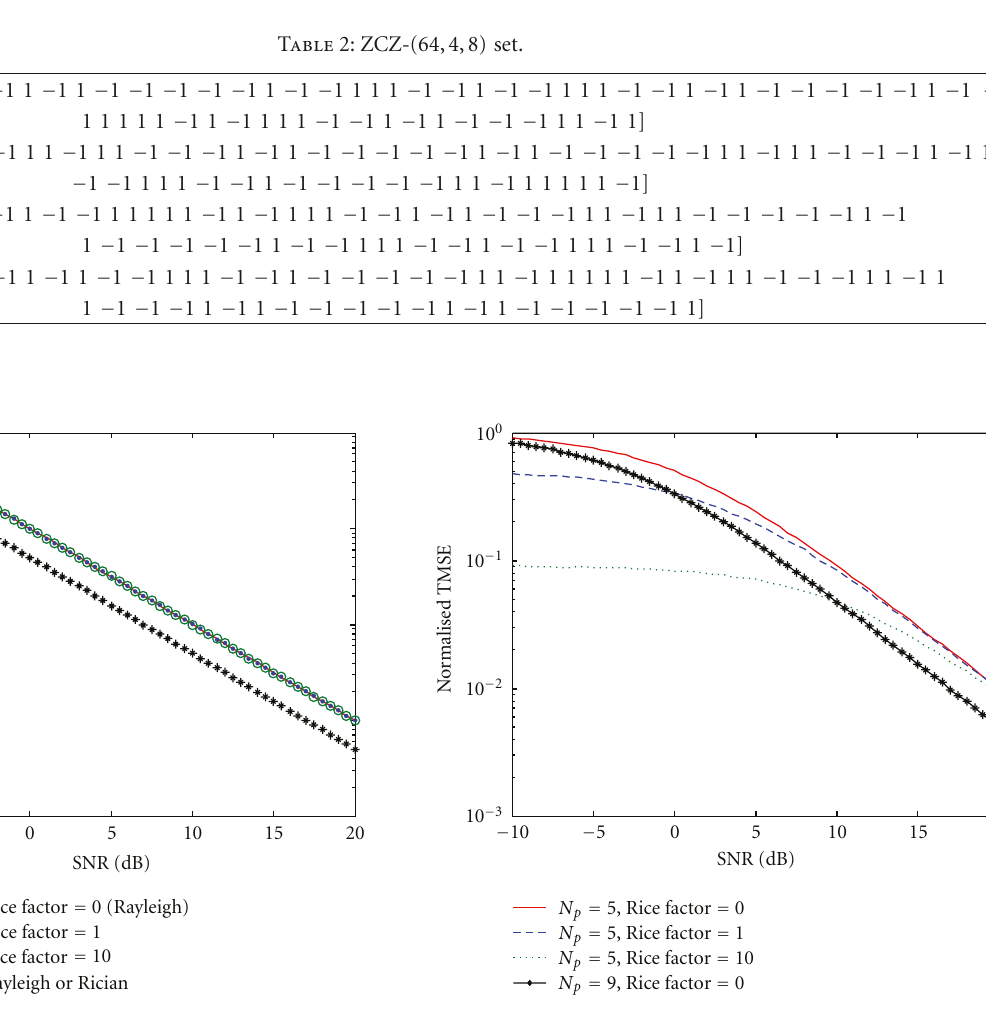
Figure 2: Normalized TMSE of the SSLS estimator in the Rayleigh and Rician fading channels ( N T = N R = 2, L = 1, N P = 5,9).